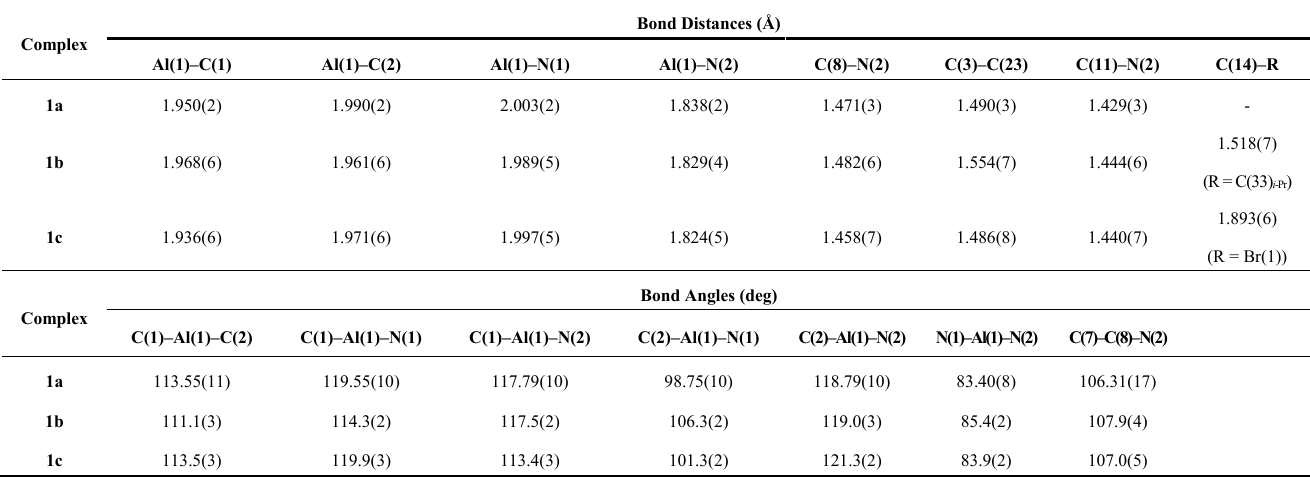
Table 2. Selected bond distances (Å) and angles (°) for 1a , 1b and 1c .